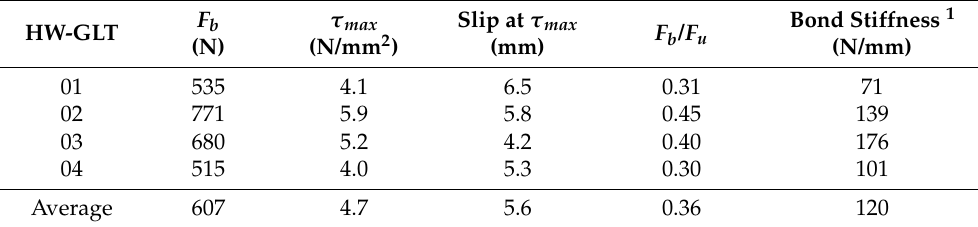
Table 2. Experimental results for the ‘HW-GLT’ systems under pull-out tests.